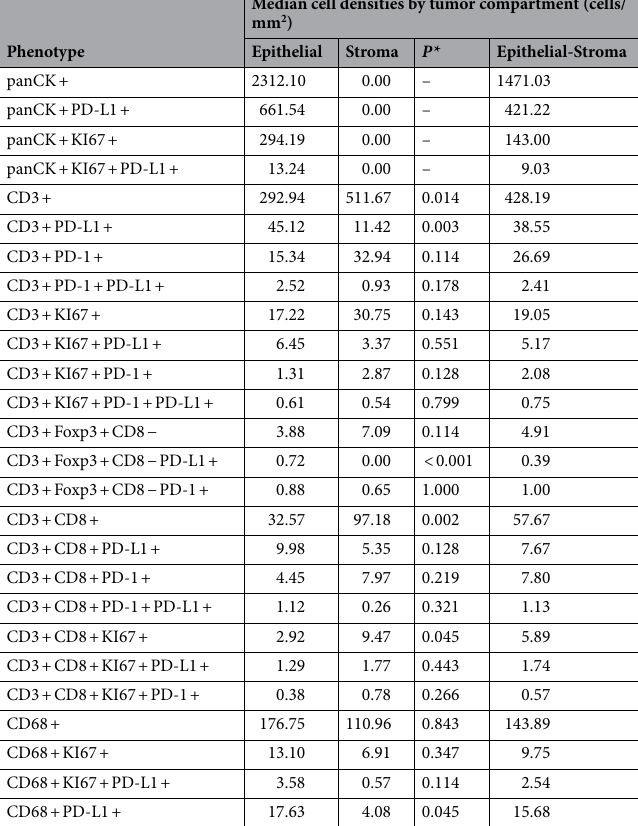
Table 1. Different cell phenotypes densities according tumor compartments (epithelial, stoma and epithelial- stroma compartment) in malignant pleural mesothelioma patients (N = 12). * P , comparison between tumor- epithelial and tumor-stroma